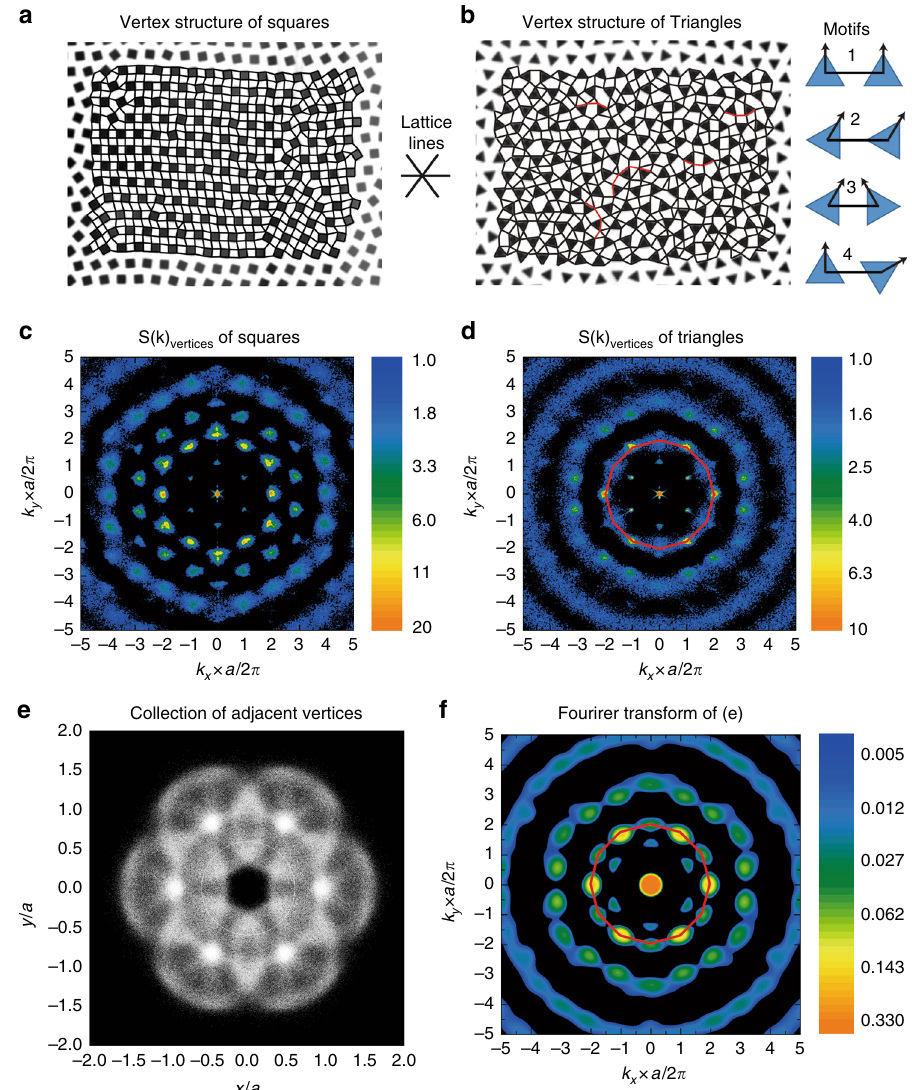
Fig. 2 The distinct structures and symmetries of vertices. a square vertices form straight stripes aligned with lattice lines. b triangle vertices look quite random but the four typical motifs shown on the right are slightly more preferred. The arrow lines in the motifs indicate the particle orientations. The red polylines in the main panel label some typical motif 3 structures which are essential for system relaxation as shown later. Note that Fig. 2a, b use the identical raw images as Fig. 1b, c. c 2D Fourier transform of square vertices indicates 6-fold symmetry. d 12-fold symmetry appears around ka /2 π = 2 for triangle vertices, with a the average particle distance. e collection of triangles ’ neighboring vertices from all con fi gurations at this density. f 2D Fourier transform of e also exhibits an obvious 12-fold symmetry around ka /2 π =